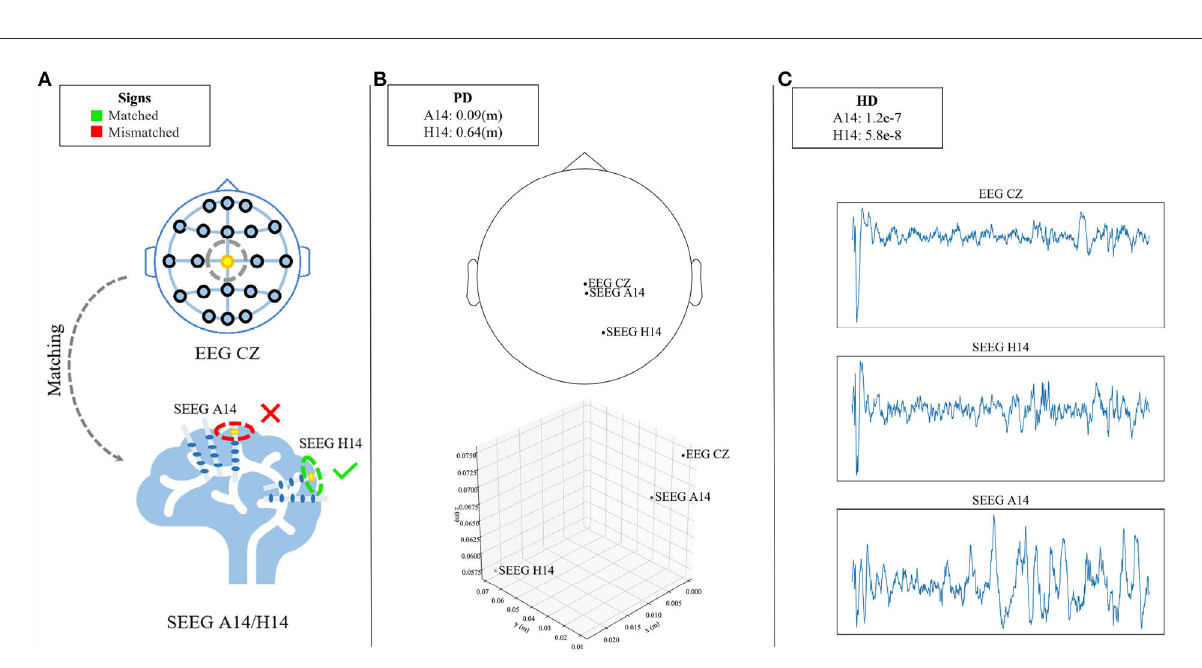
FIGURE3 Demonstration of the counterintuitive relation between signal correlation and physical distance. (A) Illustrates that the matching strategy needs to match the EEG channel ( Cz , yellow-doted at the top) to one of the candidate SEEG channels ( A14 / H14 , red-/green-circled at the bottom). Despite the closer physical distance of SEEG A14 to EEG Cz which is shown in the topological map (top of B ) and the 3-D location (bottom of B ), the farther HD is observed in A14 rather than H14 (C) . H14 is considered to be an appropriate match to Cz